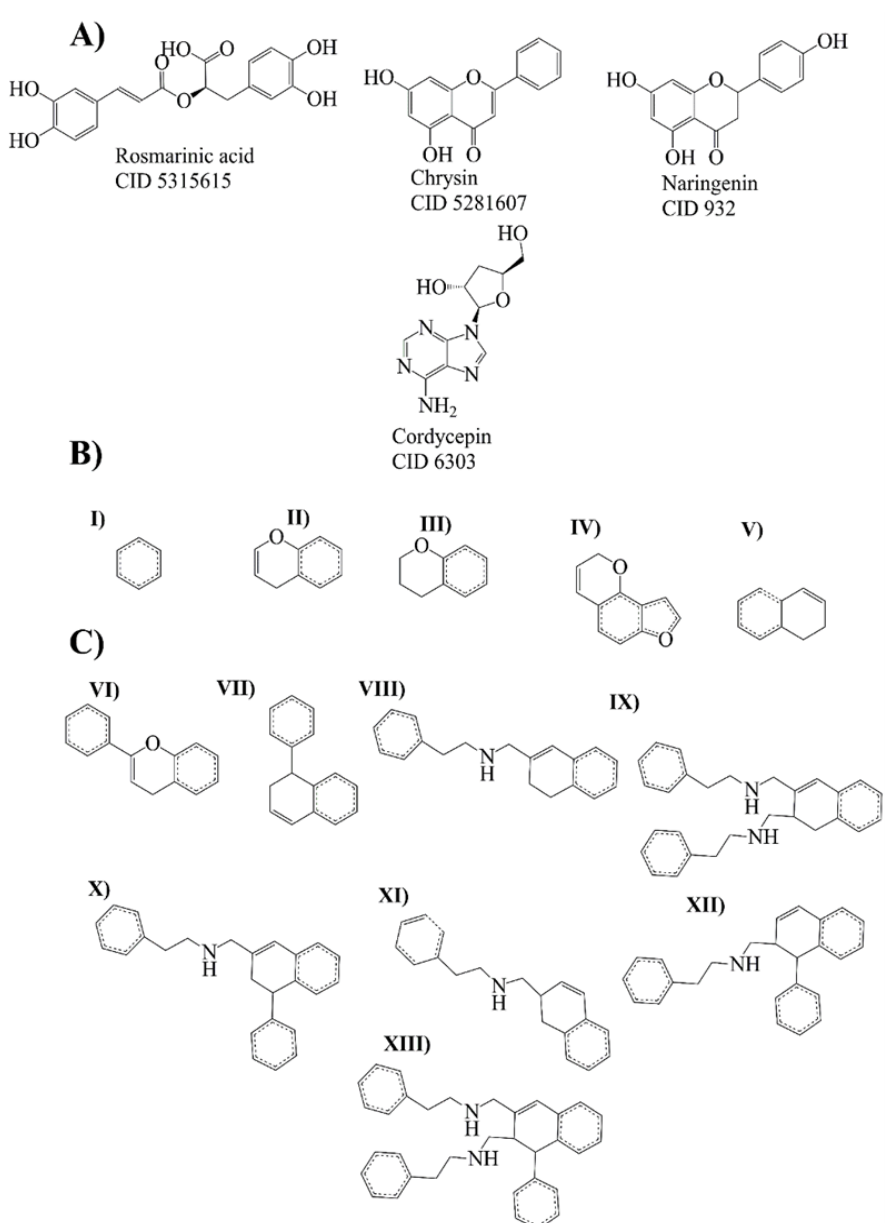
Figure 3. Molecular leaders and evolutionary library. ( A ) Molecule leaders for the library: rosmarinic acid, chrysin, naringenin, and cordycepin. ( B ) Bemis–Murcko fragments (strings) from rosmarinic acid, chrysin, naringenin (I–IV), and cordycepin (V). ( C ) Bemis–Murcko fragments (frameworks) from rosmarinic acid, chrysin, naringenin (VI), and cordycepin compounds